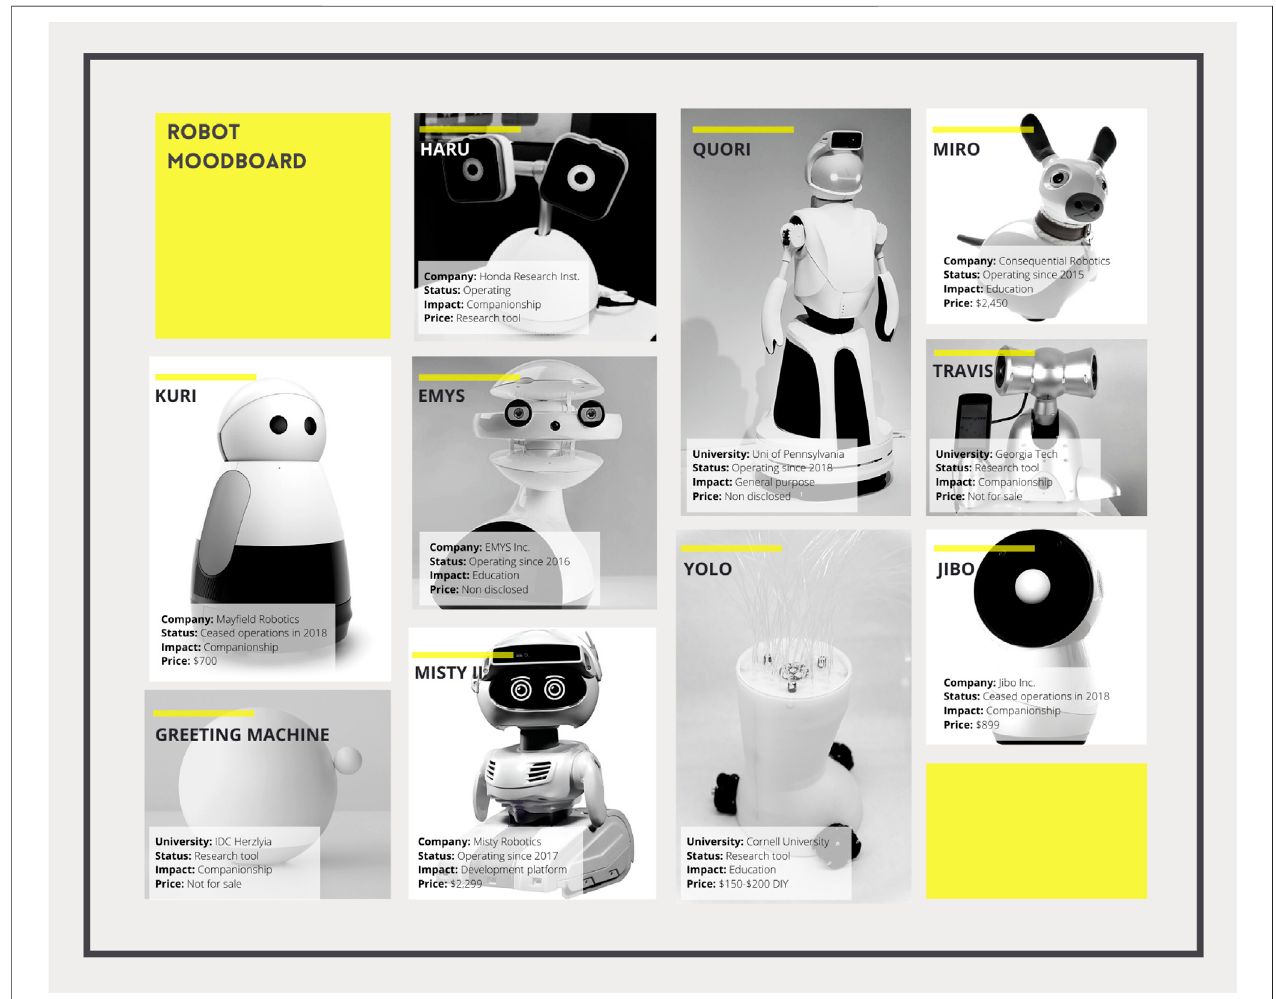
FIGURE1| Moodboardofrobotsincludedinthisstudy,includingdetailsoftherobot ’ sfoundingcompanyoruniversity,businessstatus,areaofimpact,andselling price. Prices may vary from those noted here.